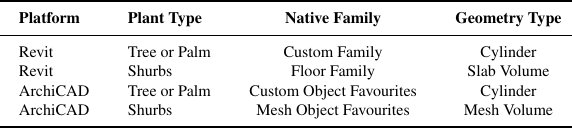
Table 4. Placeholder types in Revit and ArchiCAD